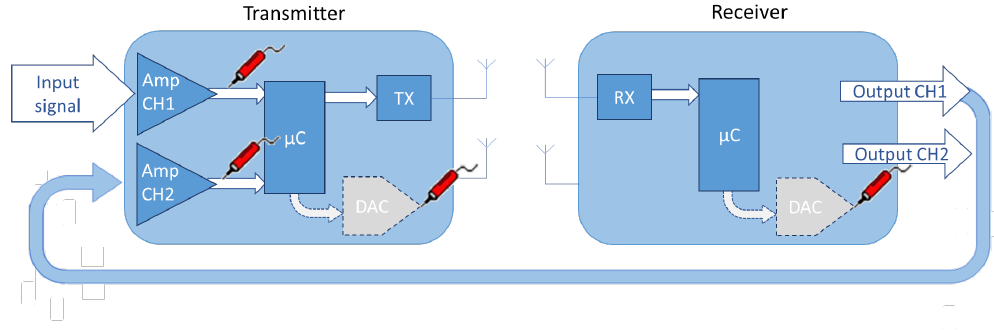
Figure 8. Configuration of the laboratory setup. Given that the noise performances of the first stage amplifier are much better than the oscilloscope’s ones, the internal amplifier is used for both the original and the received signal, using different channels in